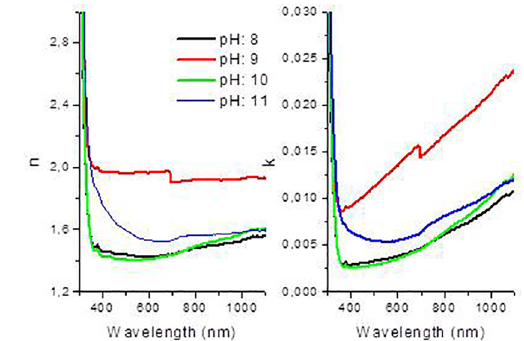
Figure 6. Plot of the refractive index and extinction coefficient of MnSe films at different pHs.